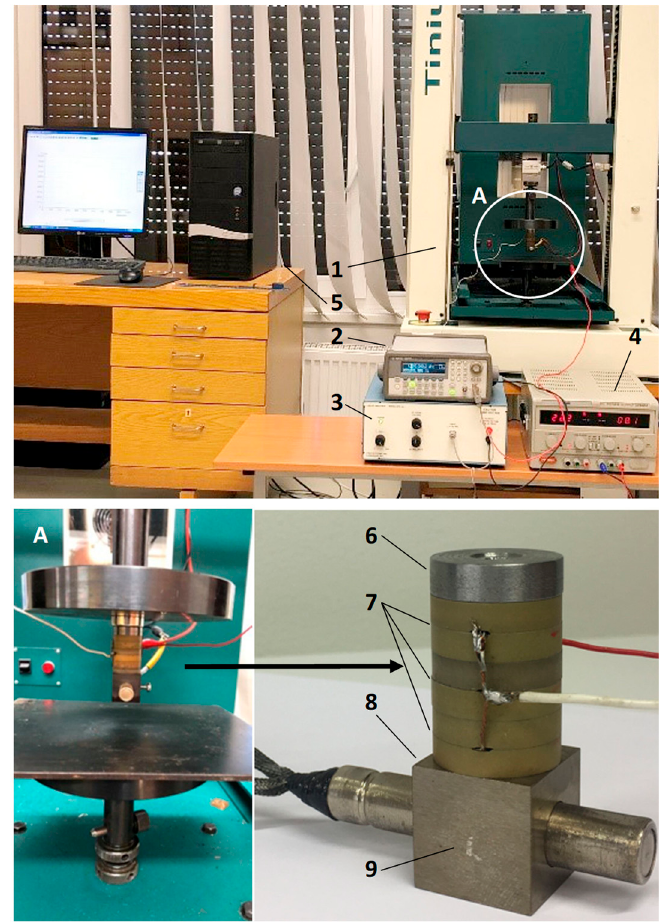
Figure 13. Setup for vibration-assisted thermal imprint of microstructures: 1, Tinius Olsen material testing machine; 2, Agilent 33220A function waveform generator; 3, power source; 4, EPA-104 (Piezo Systems Inc., Woburn, MA, USA) linear amplifier; 5, PC with the installed software for signal processing; 6, steel cap; 7, piezoceramic rings; 8, heating element; 9, cubic-shape front mass.